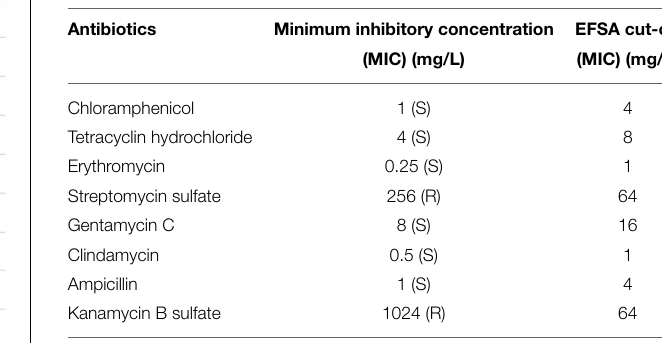
TABLE 2 | Antibiotic susceptibility of P. pentosaceus